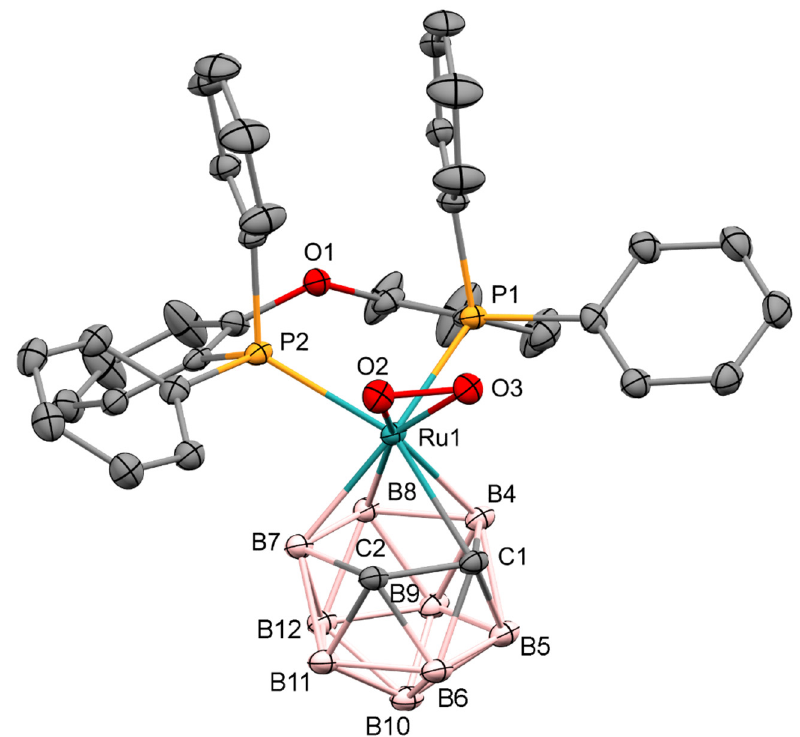
Figure 5. Molecular structure of ruthenacarborane 9 (thermal ellipsoids drawn at the 50% probability level). Hydrogen atoms have been omitted for clarity.